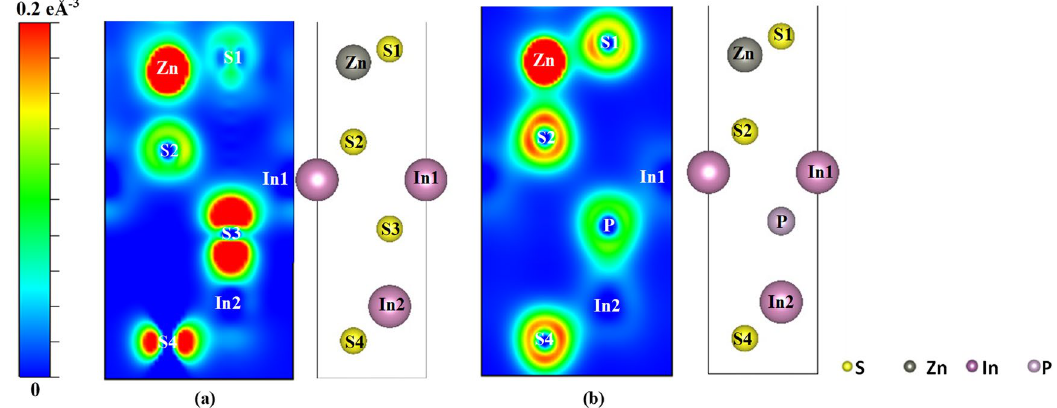
Figure 4. Charge density distribution of ( a ) pristine ZIS and ( b ) P-doped ZIS (SPD-3) at (100) doped monolayer. Respective lattice structure is provided at the side for ease of